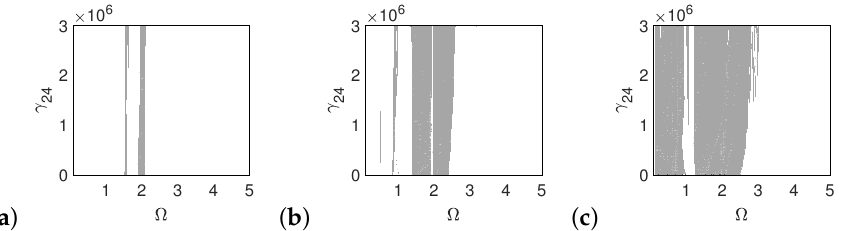
Figure 15. Regions of polyharmonic vibrations of the can in case of the pathological ear versus the nonlinear stiffness rate of the coupler ( γ 24 ) and the excitation frequency ( Ω ) under excitations of p ( a ), 5 p ( b ) and 10 p ( c